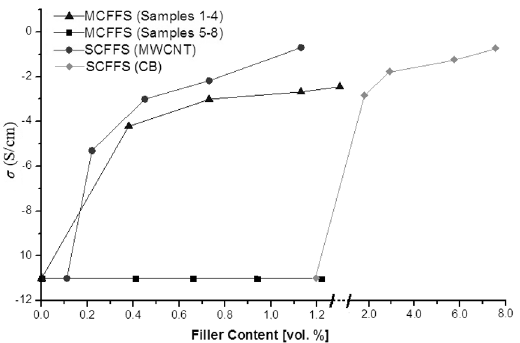
Figure 2. Experimental volumetric electrical conductivity as a function of MCFFS and SCFFS concentrations.